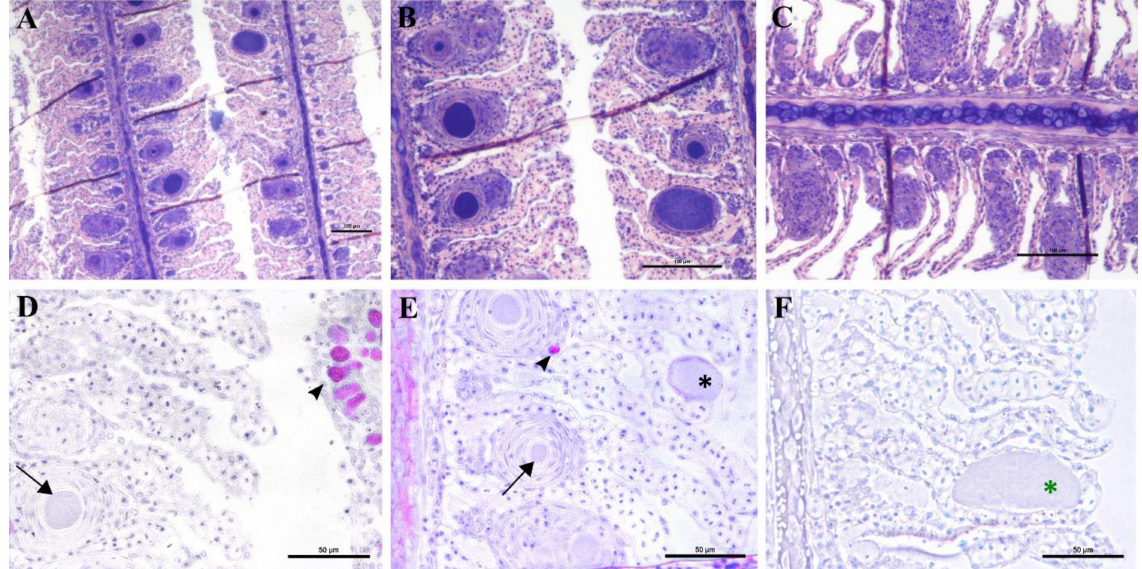
Figure 6. Histological sections of gills during and after the outbreak of epitheliocystis in greater amberjack (September 2018, approximate weight 170 g). ( A – C ) stained with polychrome stain; ( D – F ) stained with PAS stain. ( A , B ) Dark-stained cysts in the interlamellar spaces. Cysts are sur- rounded by layers of host proliferative tissue obliterating the interlamellar spaces. ( C ) Recovering fish with no cysts and residual proliferative response. ( D , E ) PAS-negative bacterial inclusions (arrow) and PAS-positive mucocytes (arrowheads). ( E ) Epitheliocystis inclusion in a PAS-positive cell (asterisk). ( F ) Epitheliocystis inclusion below the single layer of epithelial cells of the lamella (green asterisk). Lesions in outbreak samples were examined with immunohistochemical